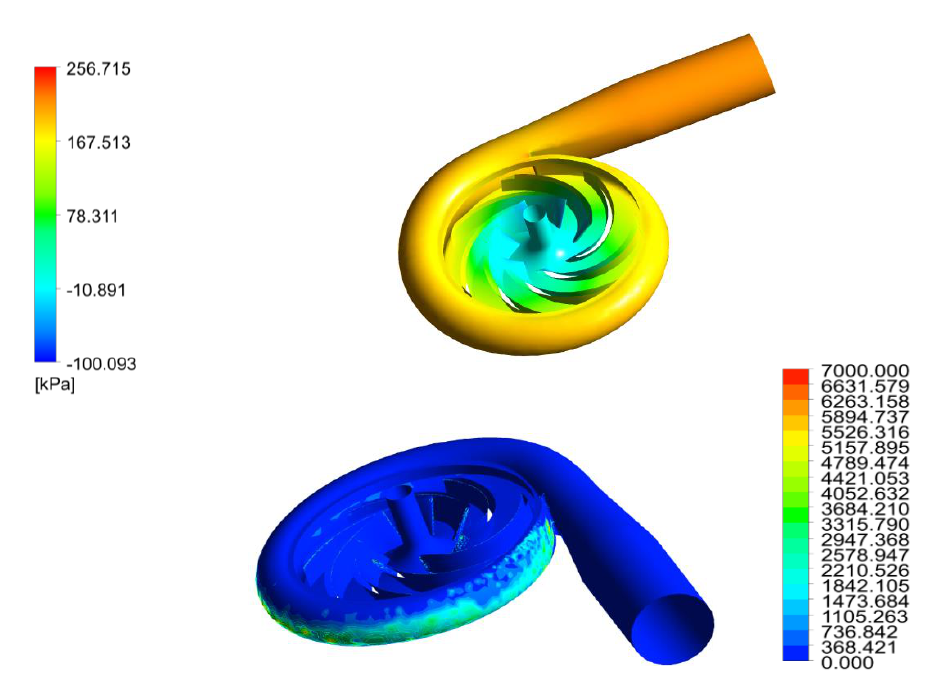
Figure 8. Validation of the computational model.